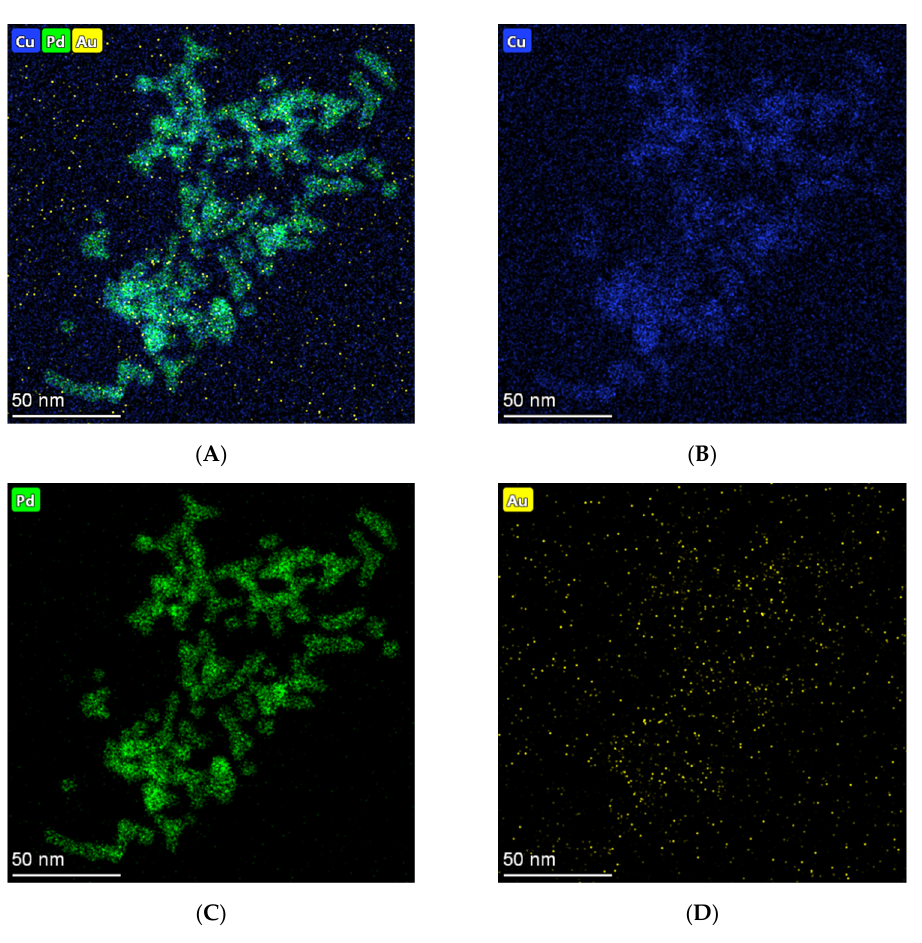
Figure 3. The elemental mapping of ( A ) the overlay of PdAuCu NPs, ( B ) Cu, ( C ) Pd, and ( D ) Au.